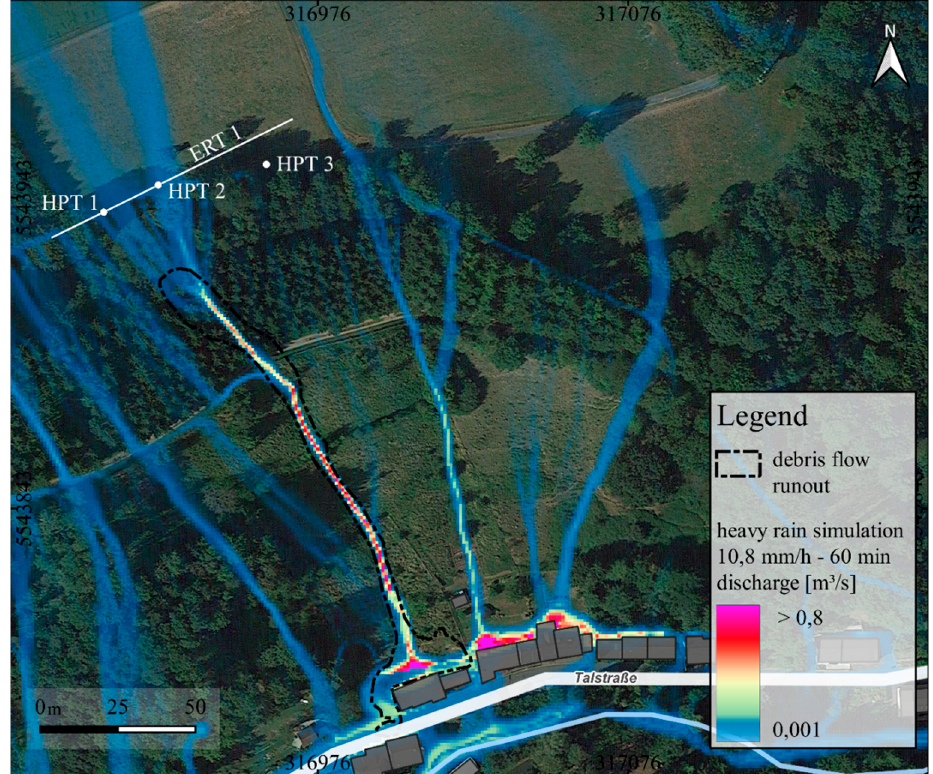
Figure 10. Comparison of the observed debris flow runout with the results of surface runoff modeling for the study area. The heavy rain simulation is based on weather data from the Wiersdorf station [27] during the hour before the mass movement occurred. The time of the triggering was assumed by local residents’ reports.